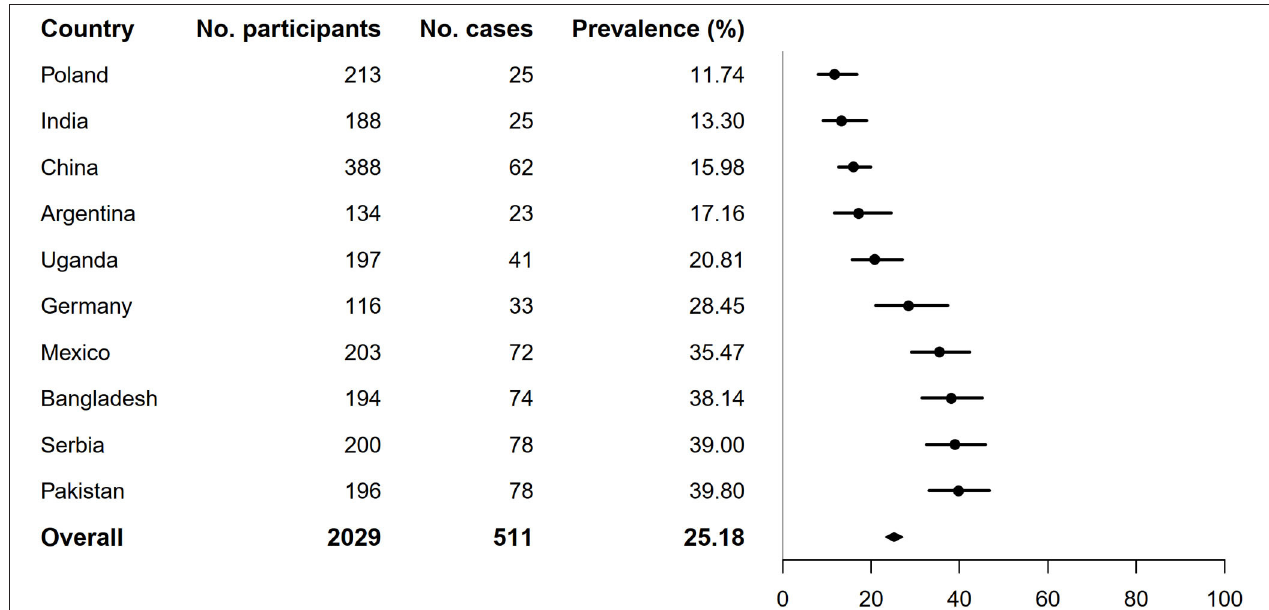
FIGURE 2 | Prevalence of diabetic neuropathy by country after excluding participants from Kenya, Italy, Ukraine and Russia.